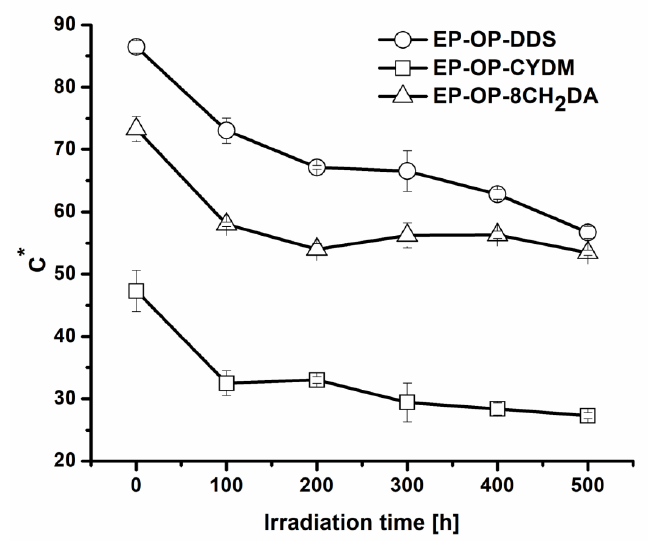
Figure 4. Variation of the chroma parameter with irradiation time.